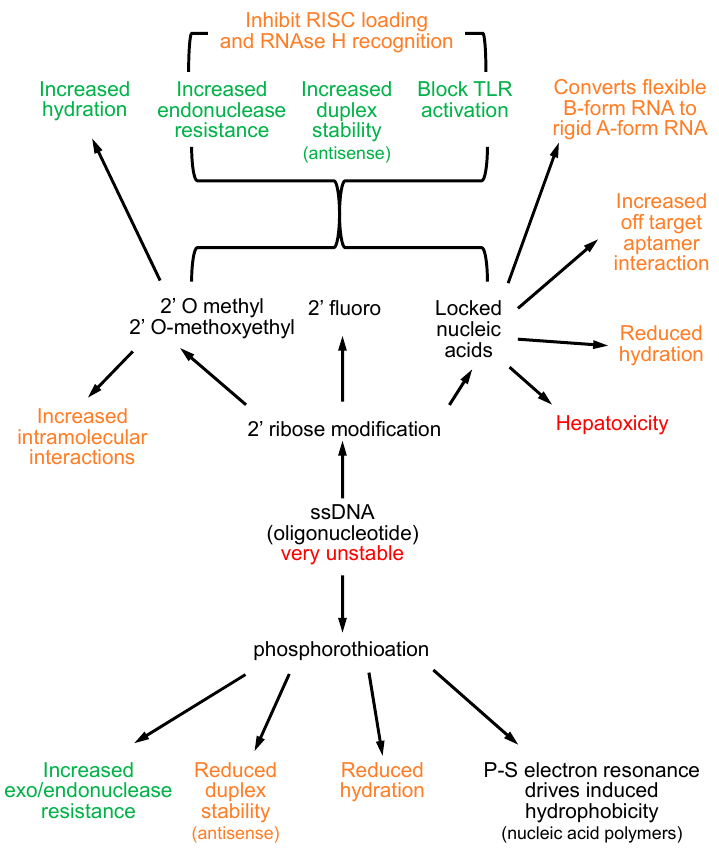
Figure 2. Impact of oligonucleotide modification on pharmacological effects. Positive effects are indicated in green, modifications with the potential to alter effects are indicated in orange. Negative effects are indicated in